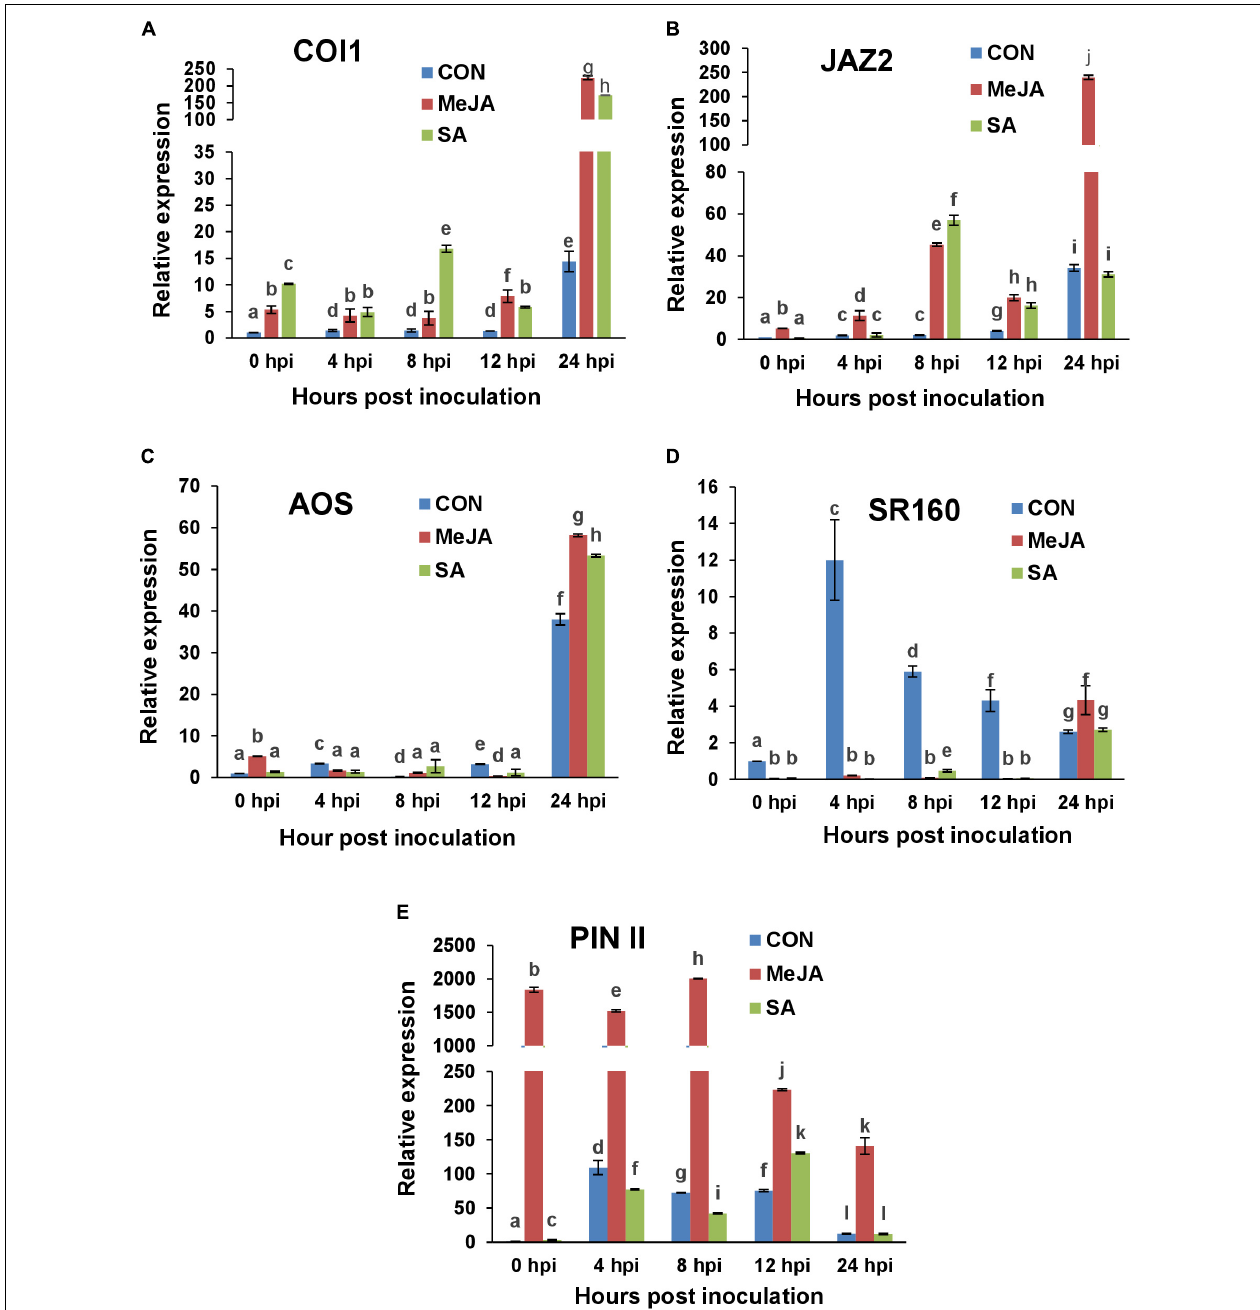
FIGURE 14 | RT-qPCR analysis of the expression of Jasmonate signaling marker genes in primed and control plants post-infection with R. solani . Graphs of Quantitative real-time RT-PCR analysis of genes over a time course in the first 24 h after infection: (A) CORONATINE INSENSITIVE 1 ( COI1 ), (B) Jasmonate zinc-finger inflorescence meristem (ZIM) domain ( JAZ2 ), (C) Allene oxide synthase ( AOS ), (D) Systemin receptor SR160 ( SR160 ), (E) Proteinase inhibitor II ( PIN II ). Bars represent standard error (SE) of the mean ( n = 3). Different letters indicate significant differences among treatments at p < 0.05, according to Duncan’s multiple range